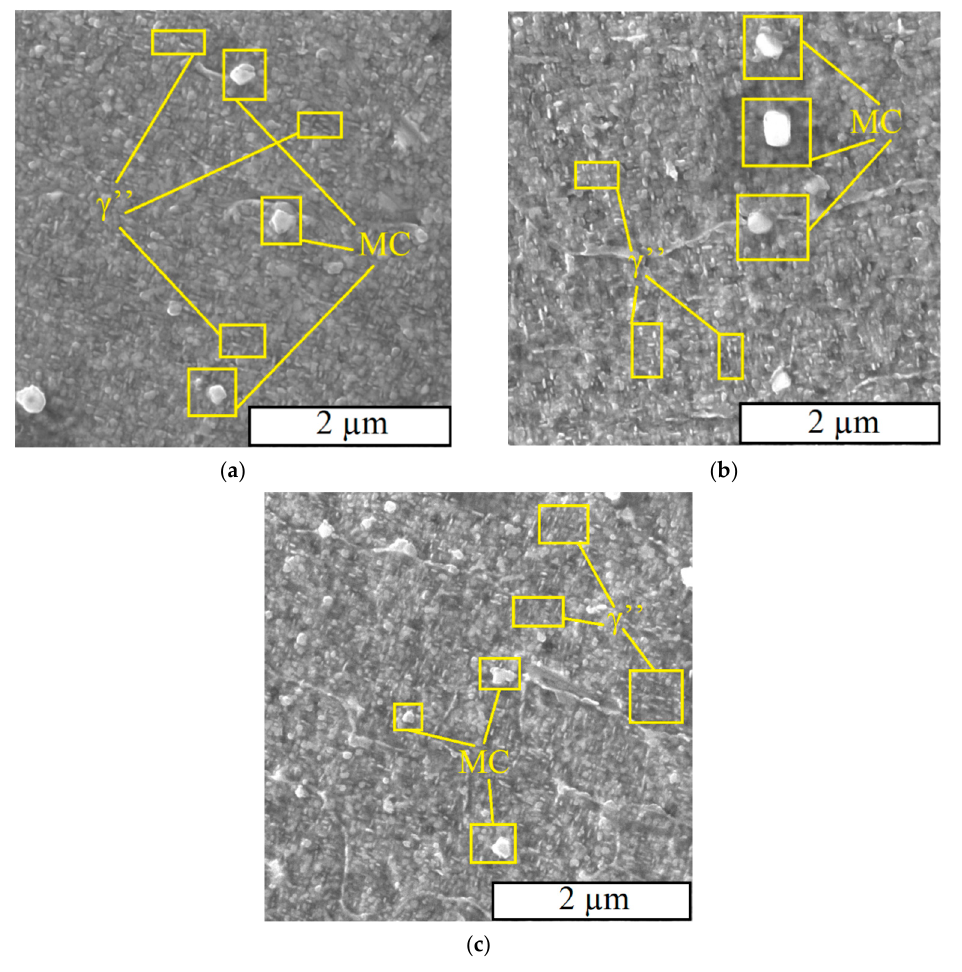
Figure 7. Microstructure of the processed samples with marked phases (secondary electron, SEM): ( a ) Inc 718, ( b ) Inc 718 + micron-TiC, ( c ) Inc 718 + nano-TiC.